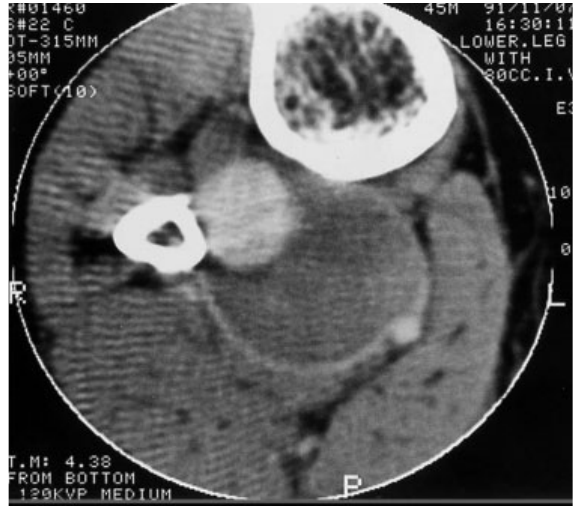
Fig. 2 Contrasted CT scan showing the actual size of the aneurysm with its pseudocapsule being presented as rim enhancement. The patent part of the aneurysm is demonstrated as a hyperdense mass compatible with fresh blood which is surrounded by isodense area compatible with old clot. An artifact may be due to the missile fragment hidden behind the bone.